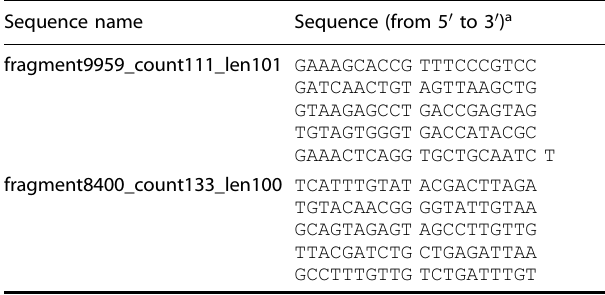
Table 2. The selected sequence was used as the template for